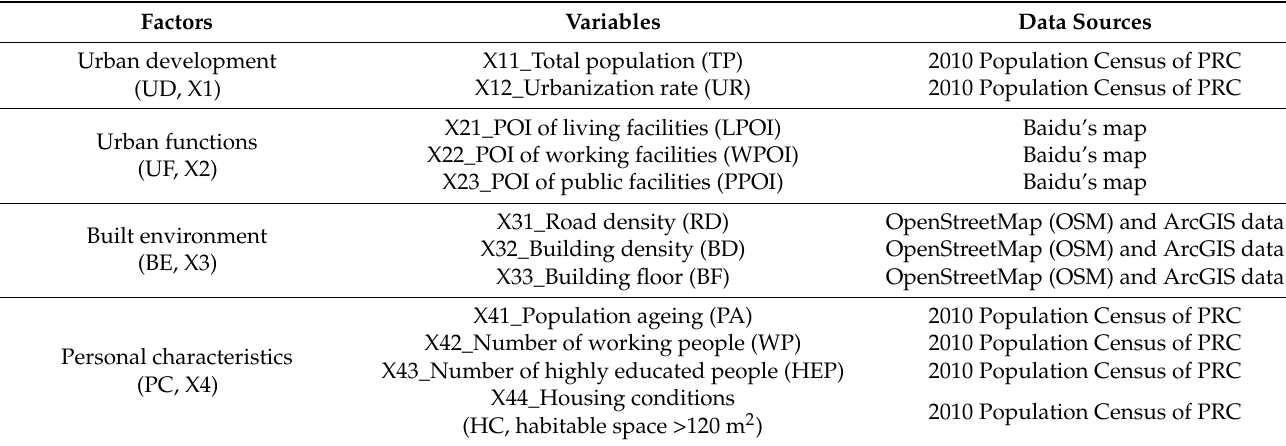
Table 1. Influencing factors, variables, and data sources of the social characteristics of administrative communities in Guangzhou.